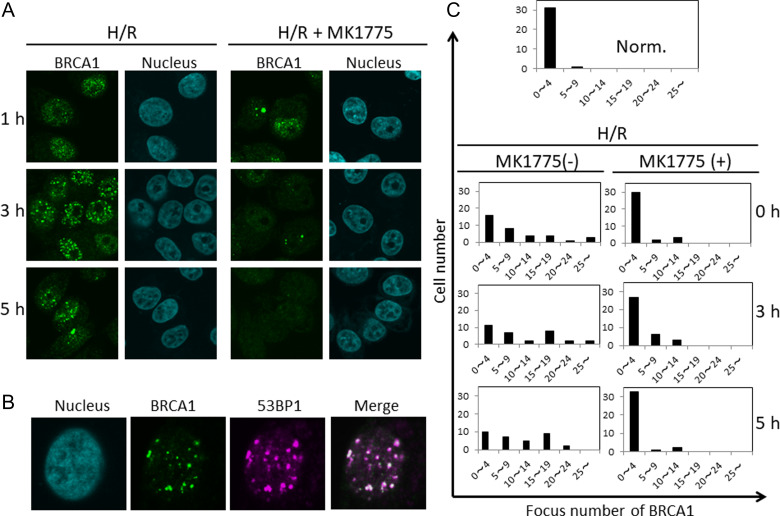
Fluorescence immunostaining for focus formation of BRCA1 in cells after treatment with H/R alone or H/R plus MK1775. (A) Fluorescence immunostaining of BRCA1 and counter-staining of nuclei with Hoechst. The cells were fixed at the indicated times after reoxygenation and prepared for immunostaining. (B) Double fluorescence immunostaining of BRCA1 and 53BP1, and counter-staining of nuclei with Hoechst. The cells were fixed 7 h after reoxygenation and prepared for immunostaining. Norm. = normoxia. (C) Histograms for BRCA1 focus number. Cells with different focus numbers were classified into six groups: 0–4, 5–9, 10–14, 15–19, 20–24, and ≥25 and shown as histograms. At least 30 cells were counted for each time point. A representative result is presented from three independent results.